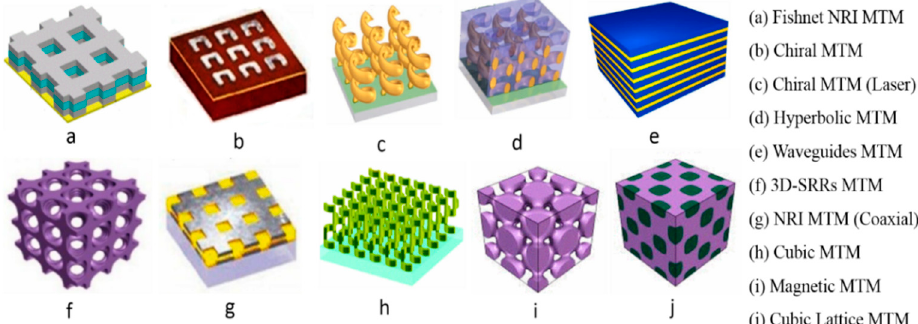
Figure 1. Examples of several meta-atom based metamaterial (MTM) structures through periodic repetition of metallic and dielectric elements: ( a ) double-fishnet negative-index metamaterial with several layers; ( b ) chiral metamaterial fabricated through stacked electron-beam lithography; ( c ) chiral metamaterial made using direct-laser writing and electroplating; ( d ) hyperbolic metamaterial made by electroplating hexagonal-hole-array templates; ( e ) metal-dielectric layered metamaterial composed of coupled plasmonic waveguides; ( f ) Split ring resonators (SRRs) oriented in all three dimensions; ( g ) wide-angle visible negative-index metamaterial based on a coaxial design; ( h ) connected cubic-symmetry negative-index metamaterial; ( i ) metal cluster-of-clusters visible-frequency magnetic metamaterial; ( j ) negative-index metamaterial composed of two sets of high-refractive-index dielectric spheres arranged on a simple cubic lattice. NRI, negative refractive index.